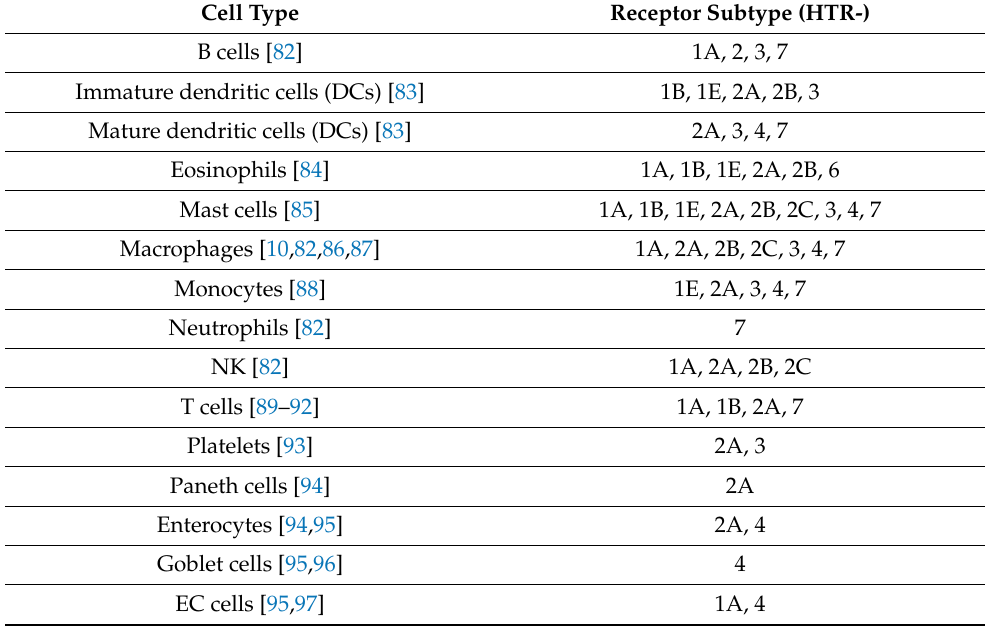
Table 3. Expression of HTRs by immune and epithelial